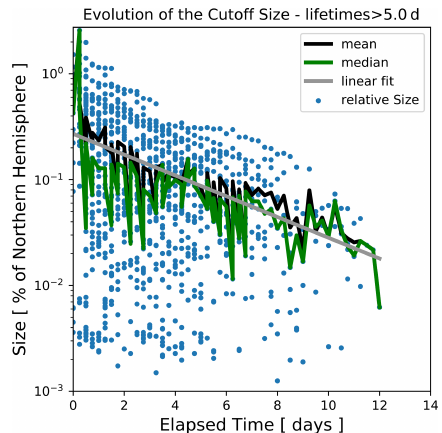
Figure 7. Decay of cascades of 6.5PVU cutoffs, for cascades that live longer than 5d. The blue dots show the relative sizes in percent of the NH of each cutoff within the cascade. Note that a cutoff of a cascade can have sizes below 0.3% of the NH, while the largest cutoff of the cascade can still exceed the threshold of 0.3% at some